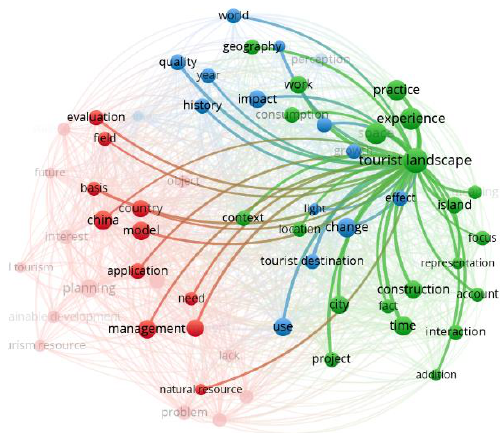
Figure 6. Co-occurrence term map by VOSviewer. Focus on the recurrent keyword: “Tourist land- scape”.